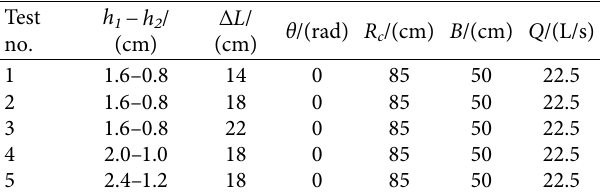
Table 5: Design of retesting working conditions of the verification